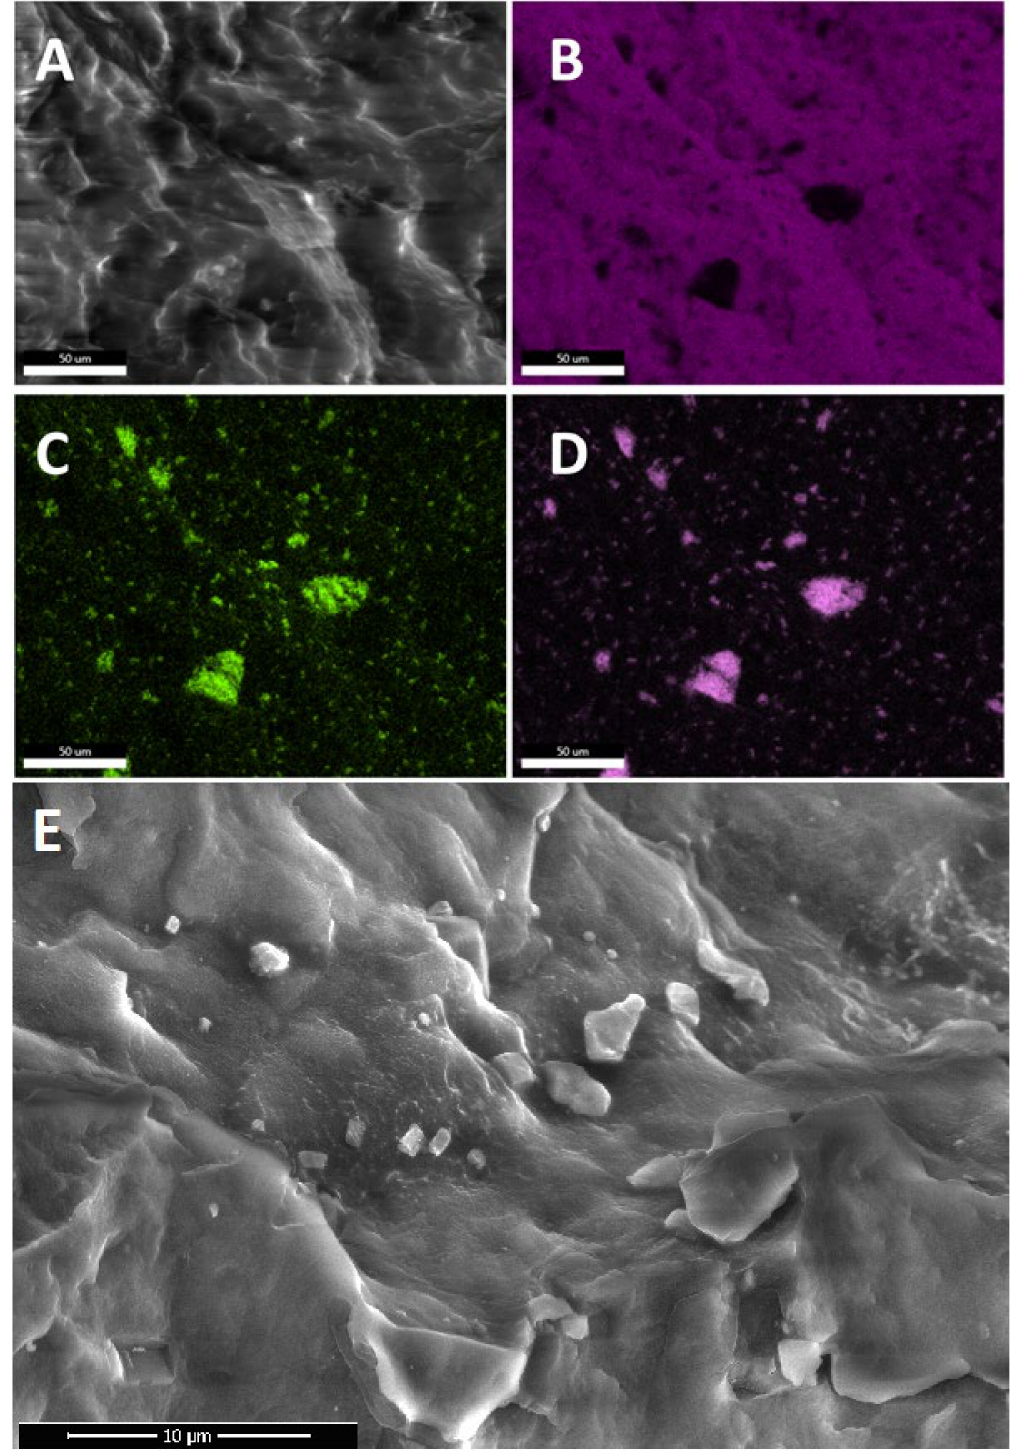
Figure 2. SEM ( A , E ) and EDS ( B – D ) images of SS-Vi/iPP 5% masterbatch. ( A )—field of view SEM, ( B )—carbon EDS, ( C )—oxygen EDS, ( D )—Silicon EDS, ( E )—high resolution